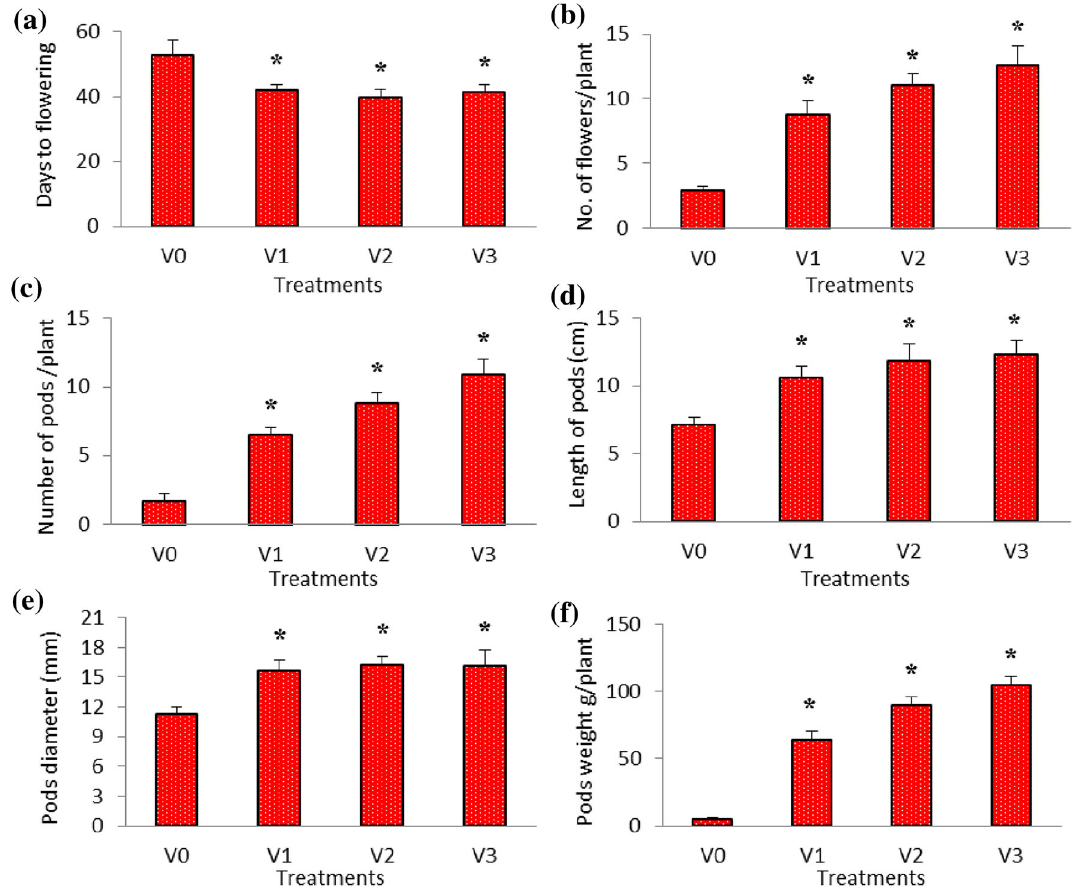
Fig. 2 Effect of salvinia vermicompost on a early flowering; b number of flowers per plant; c number of pods per plant; d length of pods; e diameter of pods; and f weight of pods per plant,